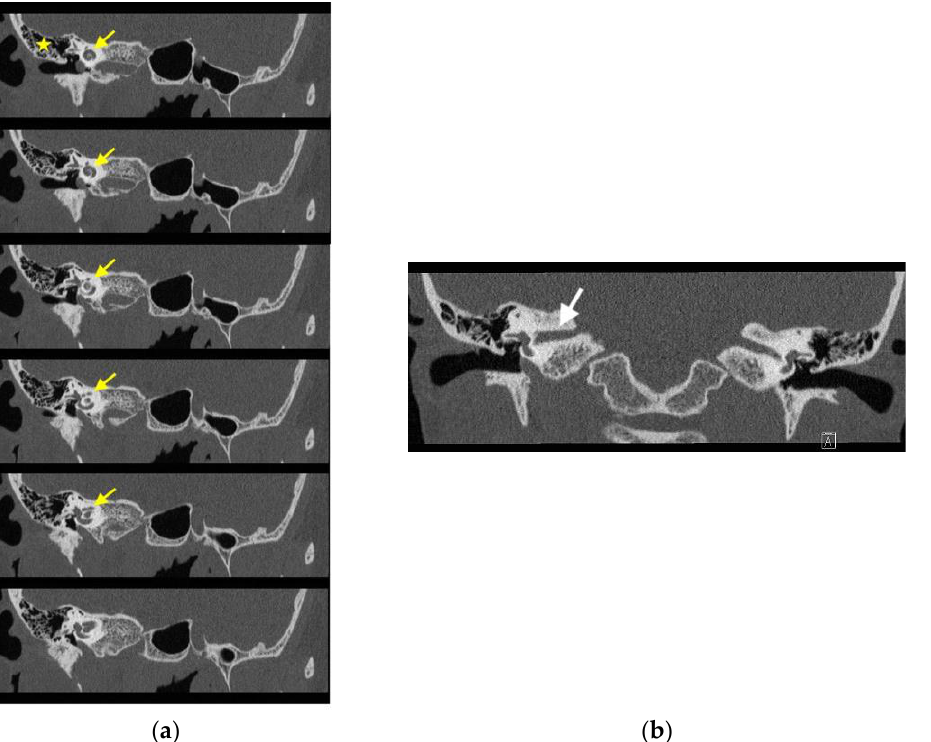
Figure 4. High-resolution computed tomography (HRCT) revealing no significant abnormalities in the right external auditory canal (EAC), middle ear, inner ear, and internal auditory canal (IAC). ( a ) In the oblique view, the EAC was patent and normal in configuration. The tympanic cavity and mastoid cells (asterisk) were clear. The configuration of the cochlea (yellow arrows), vestibule, and semicircular canals was normal. ( b ) In the coronal view, no significant abnormalities were noted in the IAC (white arrow) and petrosal apex.